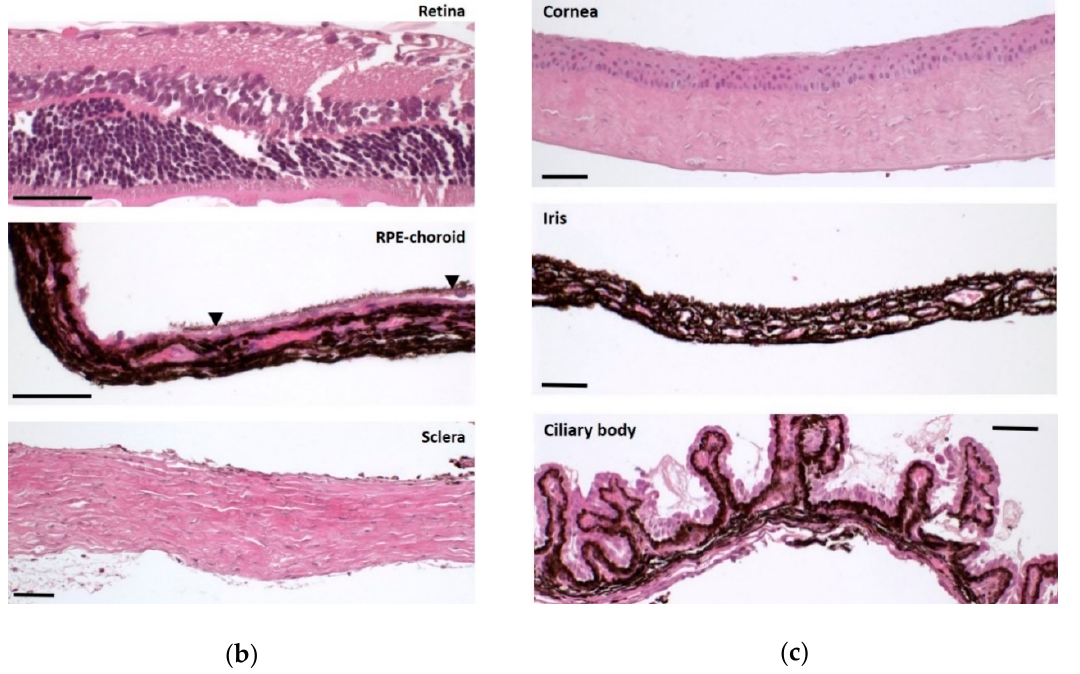
Figure 1. Histology images of BN rat ocular tissues demonstrating the low cross-tissue contamination observed with the presented separation technique. All bars: 50 µm. ( a ) Posterior segment with ganglion cell layer (GCL, black arrows), inner plexiform layer (IPL), inner nuclear layer (INL), outer plexiform layer (ONL), outer nuclear layer (ONL), retinal pigment epithelium (RPE, black arrow heads), choroid, and sclera. ( b ) Separated posterior segment tissue layers from top to bottom: retina, RPE-choroid, sclera. ( c ) Separated anterior segment tissue layers from top to bottom: cornea, iris, ciliary body.